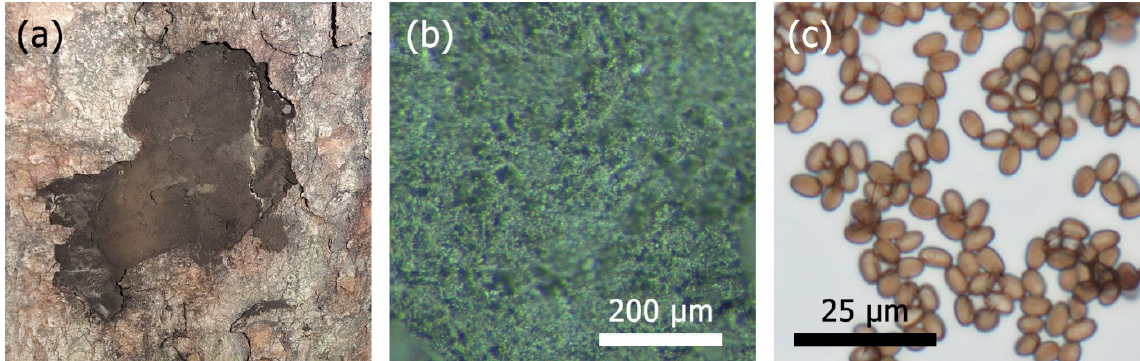
Figure 1. The first suspicious case of sooty bark disease of sycamore maple ( Acer pseudoplatanus ) caused by Cryptostroma corticale in Slovenia: ( a ) The bark cracked and peeled off, revealing dark brown masses of conidia; ( b ) masses of dark brown conidia; ( c ) ovoid, dark brown conidia.